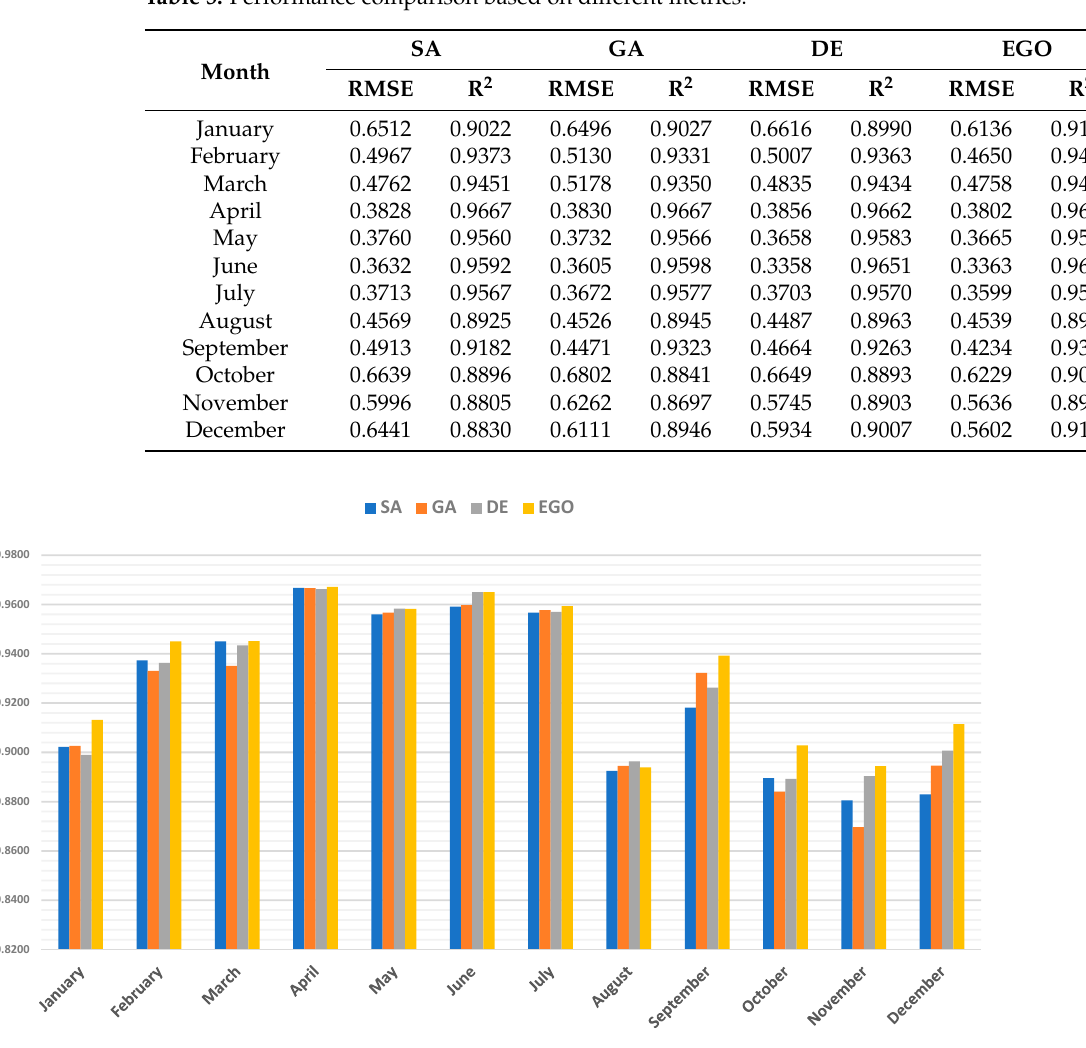
Figure 10. R-Square values for monthly parameter estimation per each technique (own elaboration).